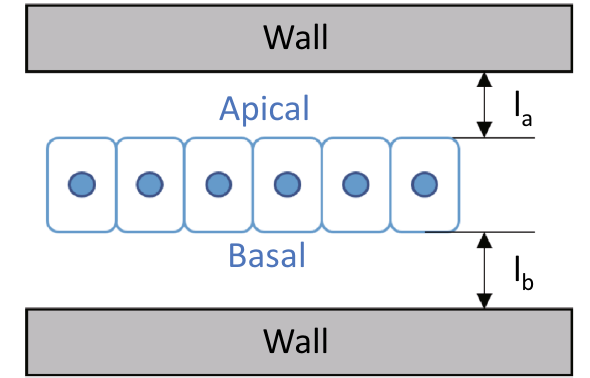
Figure 1. Schematic diagram of epithelial tissue and the elastic wall that provides physical constraint to simulate cell proliferation dynamics in our model. The elastic walls are located at the apical and basal sides of the epithelium, and the distance between them is denoted by l a and l b ,